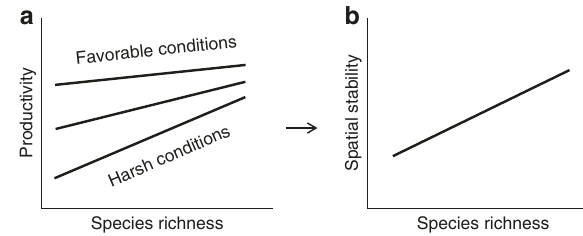
Fig. 1 Hypothetical relationships between richness, productivity and stability in natural ecosystems. a The local effect of species richness on primary productivity is expected to vary along environmental gradients, leading to a convergence of richness – productivity relationships with increasing diversity. b As a result, the spatial stability of productivity between communities that experience different environments should increase as plant richness